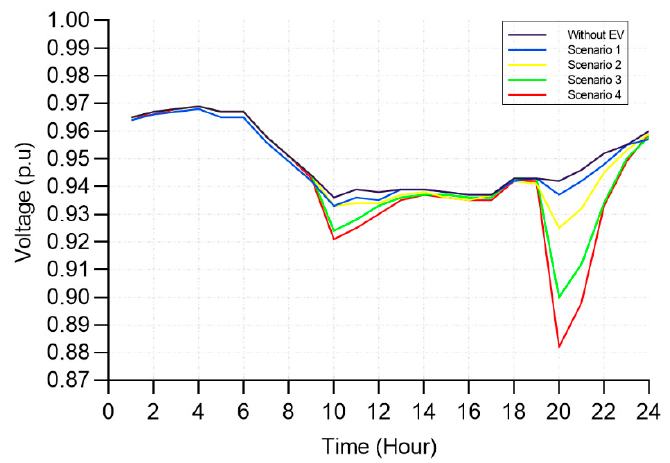
Figure 9. Voltage profile for various scenarios with uncoordinated charging.